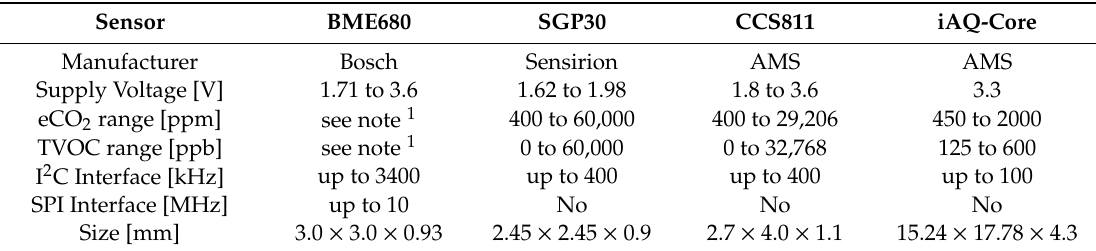
Table 1. Digital metal oxide (MOX) gas sensors main characteristics. TVOC: total VOC.